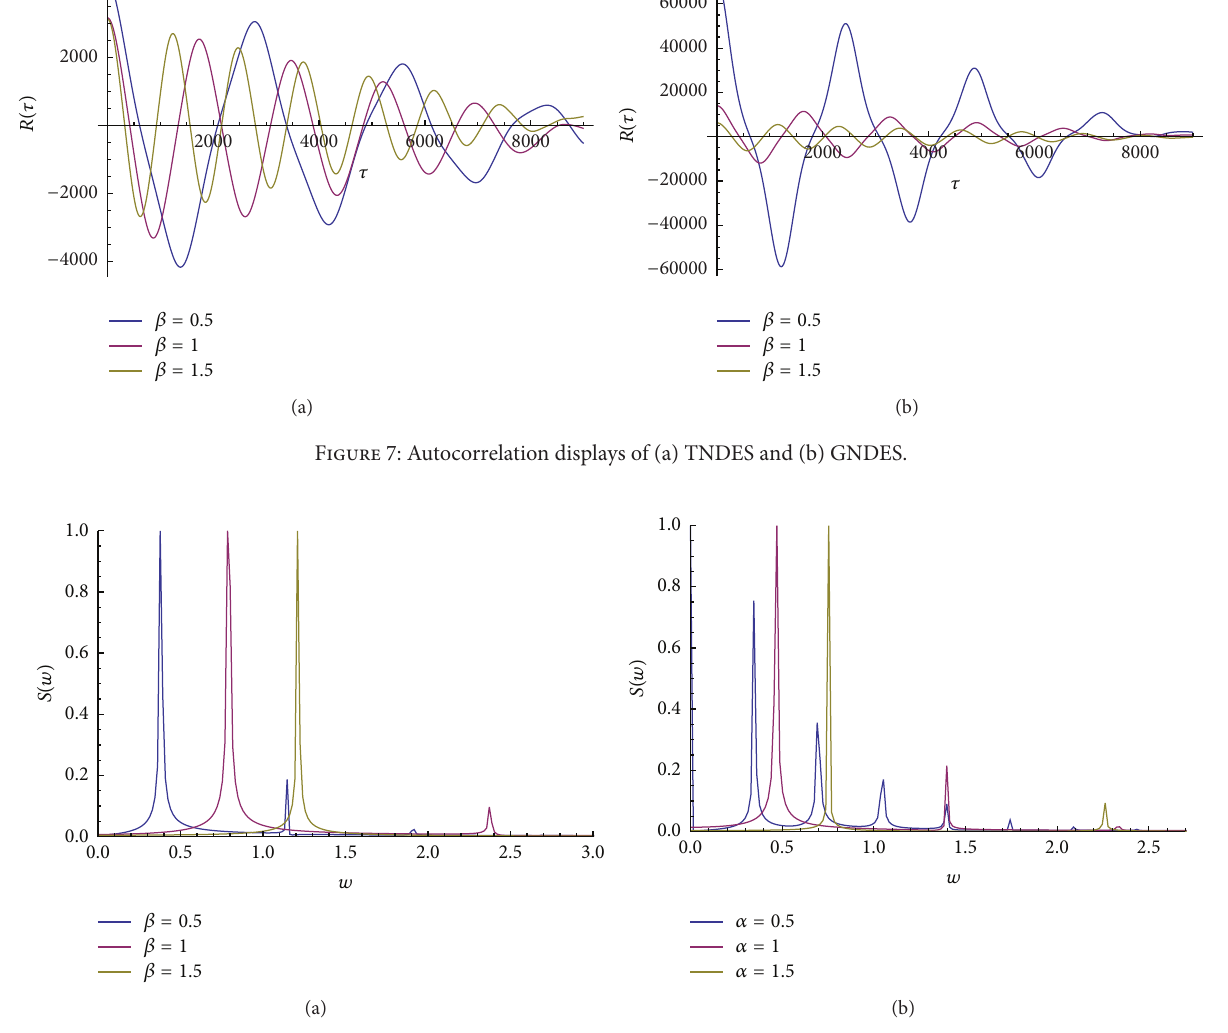
Figure 8: Power spectrum displays of (a) TNDES and (b)